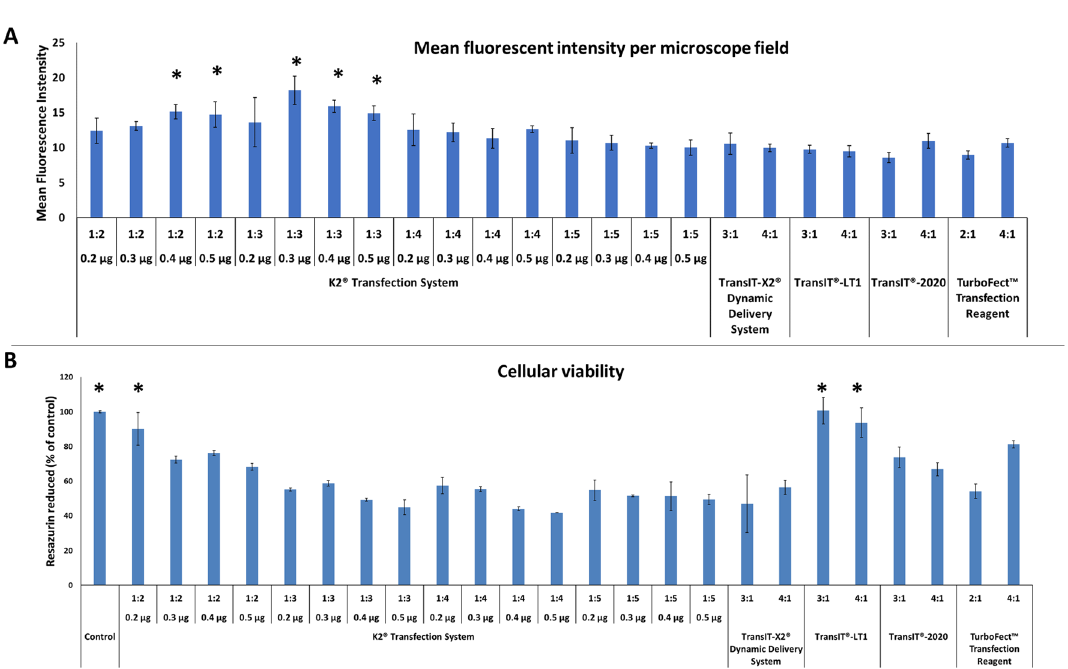
Figure 3. Comparison of transfection efficiency between commercial transfection reagents. HDFs were transfected using the K2 Transfection System, the TransIT-X2 Dynamic Delivery System, the TransIT-2020 Transfection Reagent, the TransIT-LT1 Transfection Reagent and TurboFect and analysed after two days. Quantification of mean fluorescence intensity per microscope field is shown in ( A ) and cellular viability is shown in ( B ). ANOVA statistical test. * p ≤ 0.05. N =